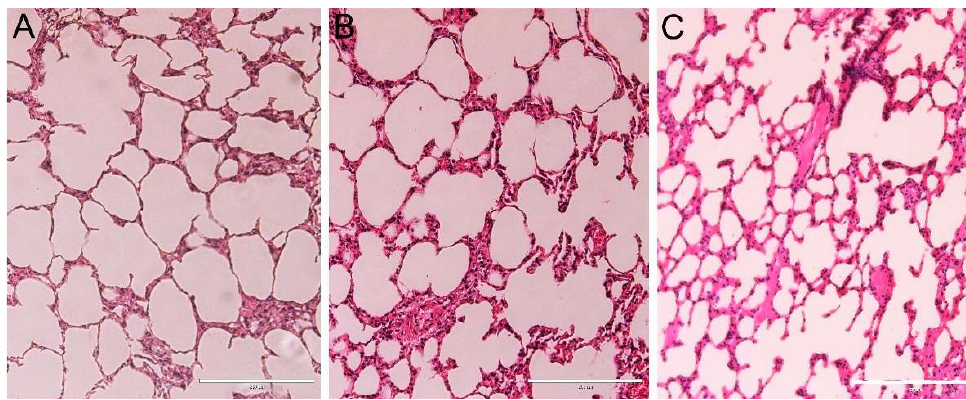
Figure 9. Representative micrographs of lungs from ( A ) the control group, presenting thin inter- alveolar septa, and the DMSA-MNP treated groups ( B ) T0.5 and ( C ) T5, showing discreet inter- alveolar septa thickening. 20× magnification. Scale bar = 200 µm.